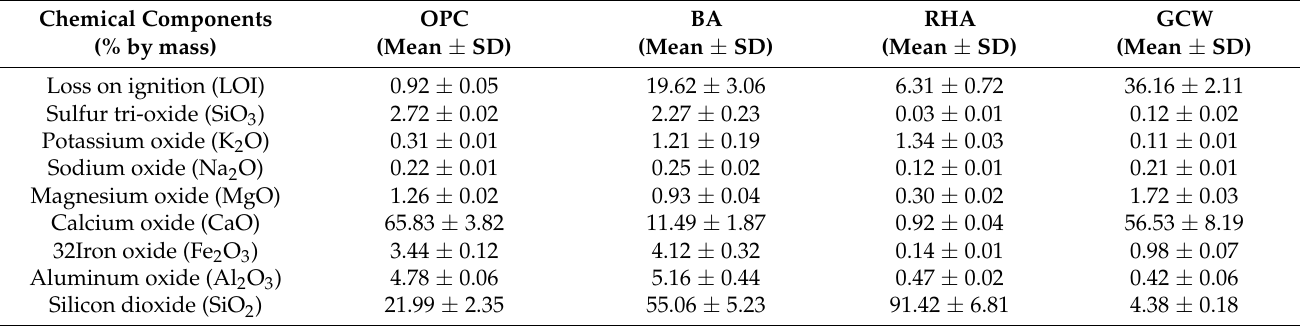
Table 2. Chemical components of OPC, BA, RHA, and